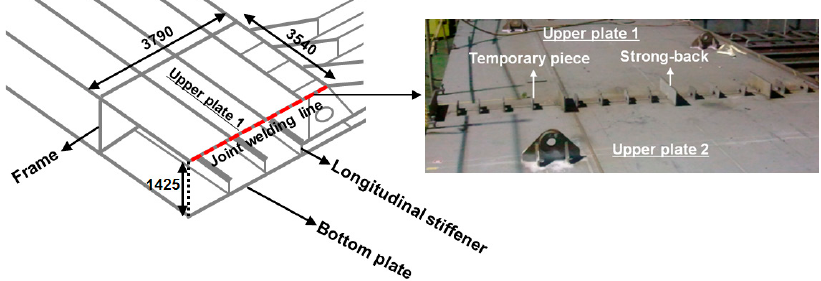
Figure 15. Panel block model for method validation.